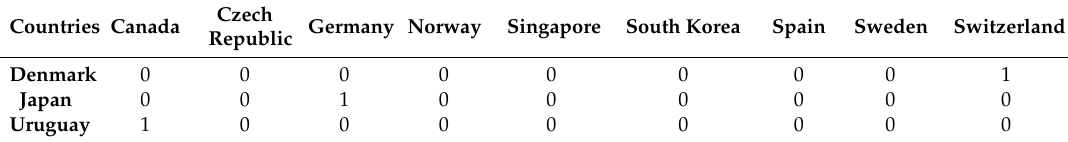
Table 7. Minimal subset of countries (e ffi ciency constructs) to be removed in order to make the respective country e ffi cient. For Denmark, Japan and Uruguay, the countries not listed all contain zeros. The full table for all countries is available in the ESI, Table S6. Countries